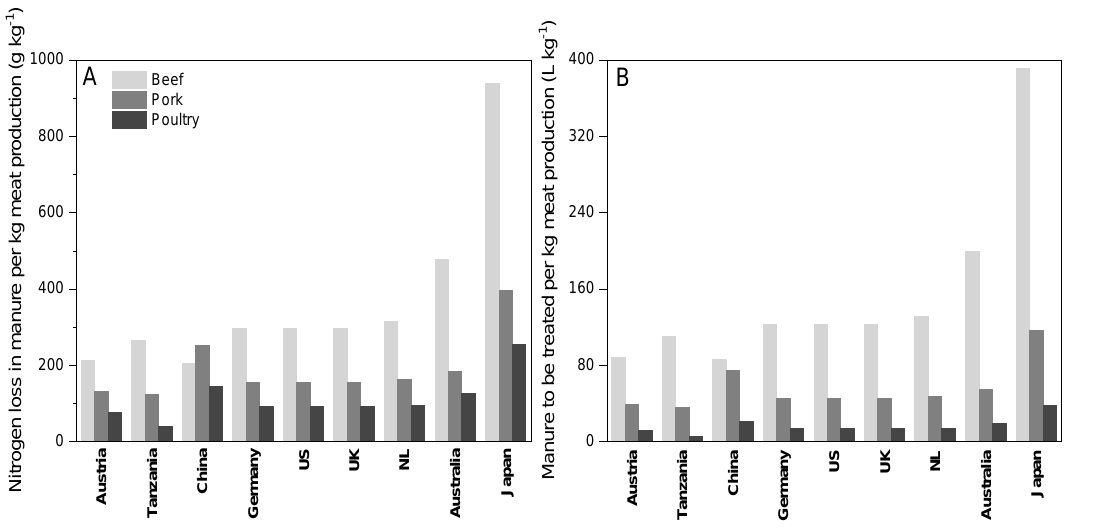
Figure 3. ( A ) Nitrogen loss in manure (NM) and ( B ) the quantity of manure (QM) to be treated for nitrogen recovery per 1 kg beef, pork and poultry meat production, respectively, among the different